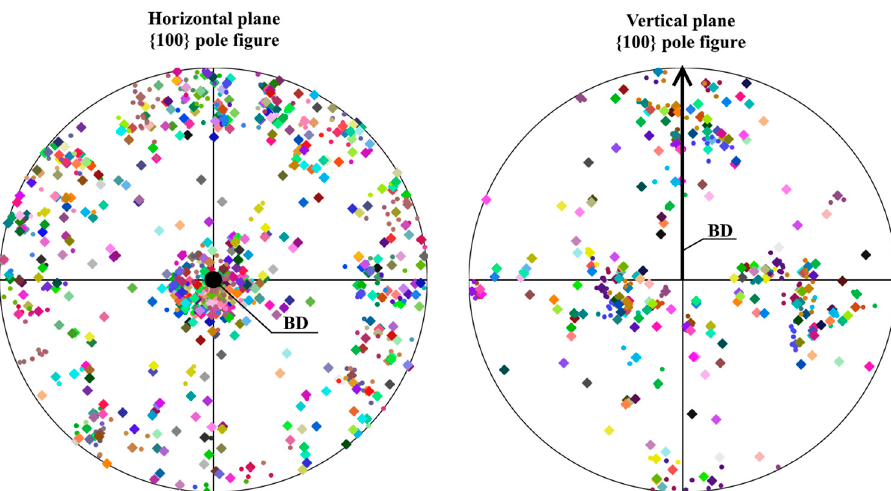
Figure 8. Pole figures of the horizontal and vertical planes of selective laser melting (SLM) Inconel 718. Each square represents the average orientation of the {100} crystallographic planes of the grains, as shown in the electron backscatter diffraction (EBSD) mapping in Figure 5, with the same colors used for each grain. The small circles represent the average orientation of the subgranular domains.